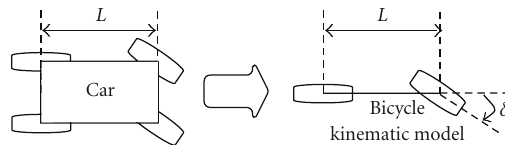
Figure 4: The bicycle model synthesizes the displacement of a four-wheel vehicle, through the displacement of two wheels whose centers are connected by a rigid axis of length L . Ackerman’s theory serves to estimate the steering angle of the front axis of a vehicle traveling at low speed.